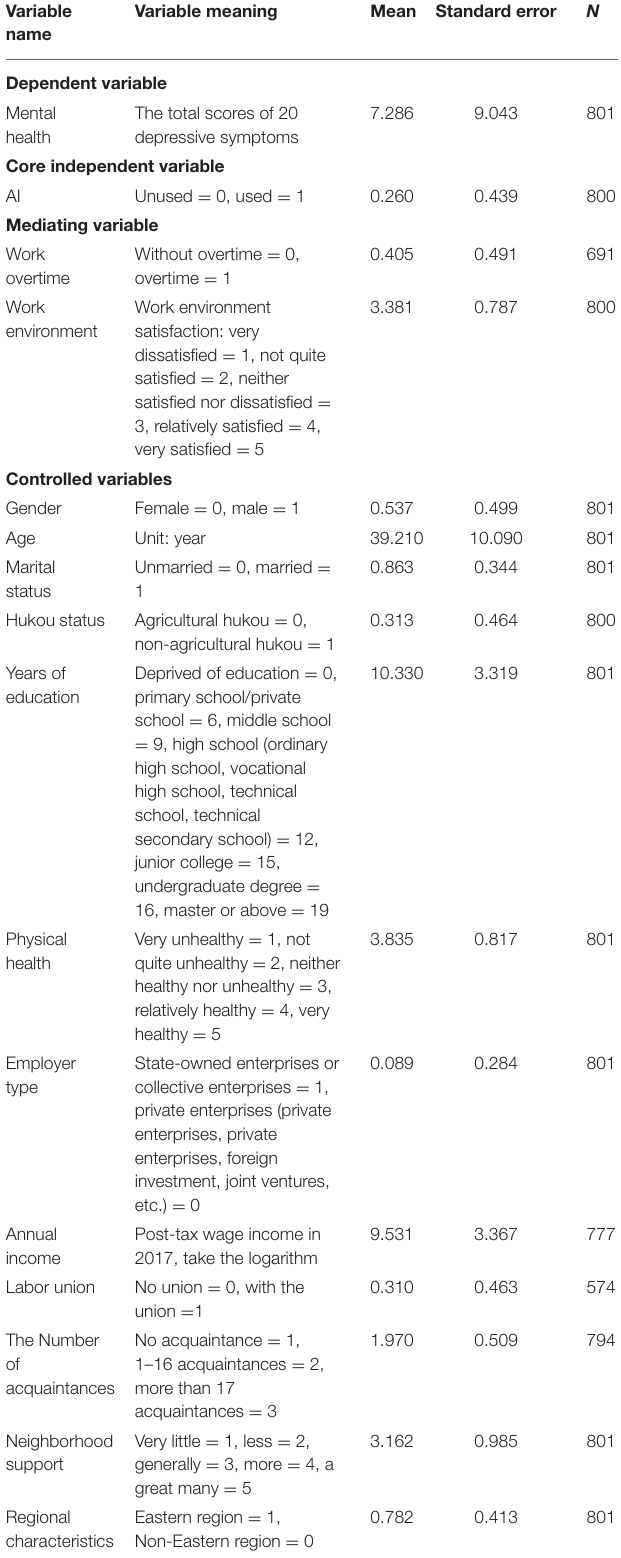
TABLE 1 | Variable implications and descriptive